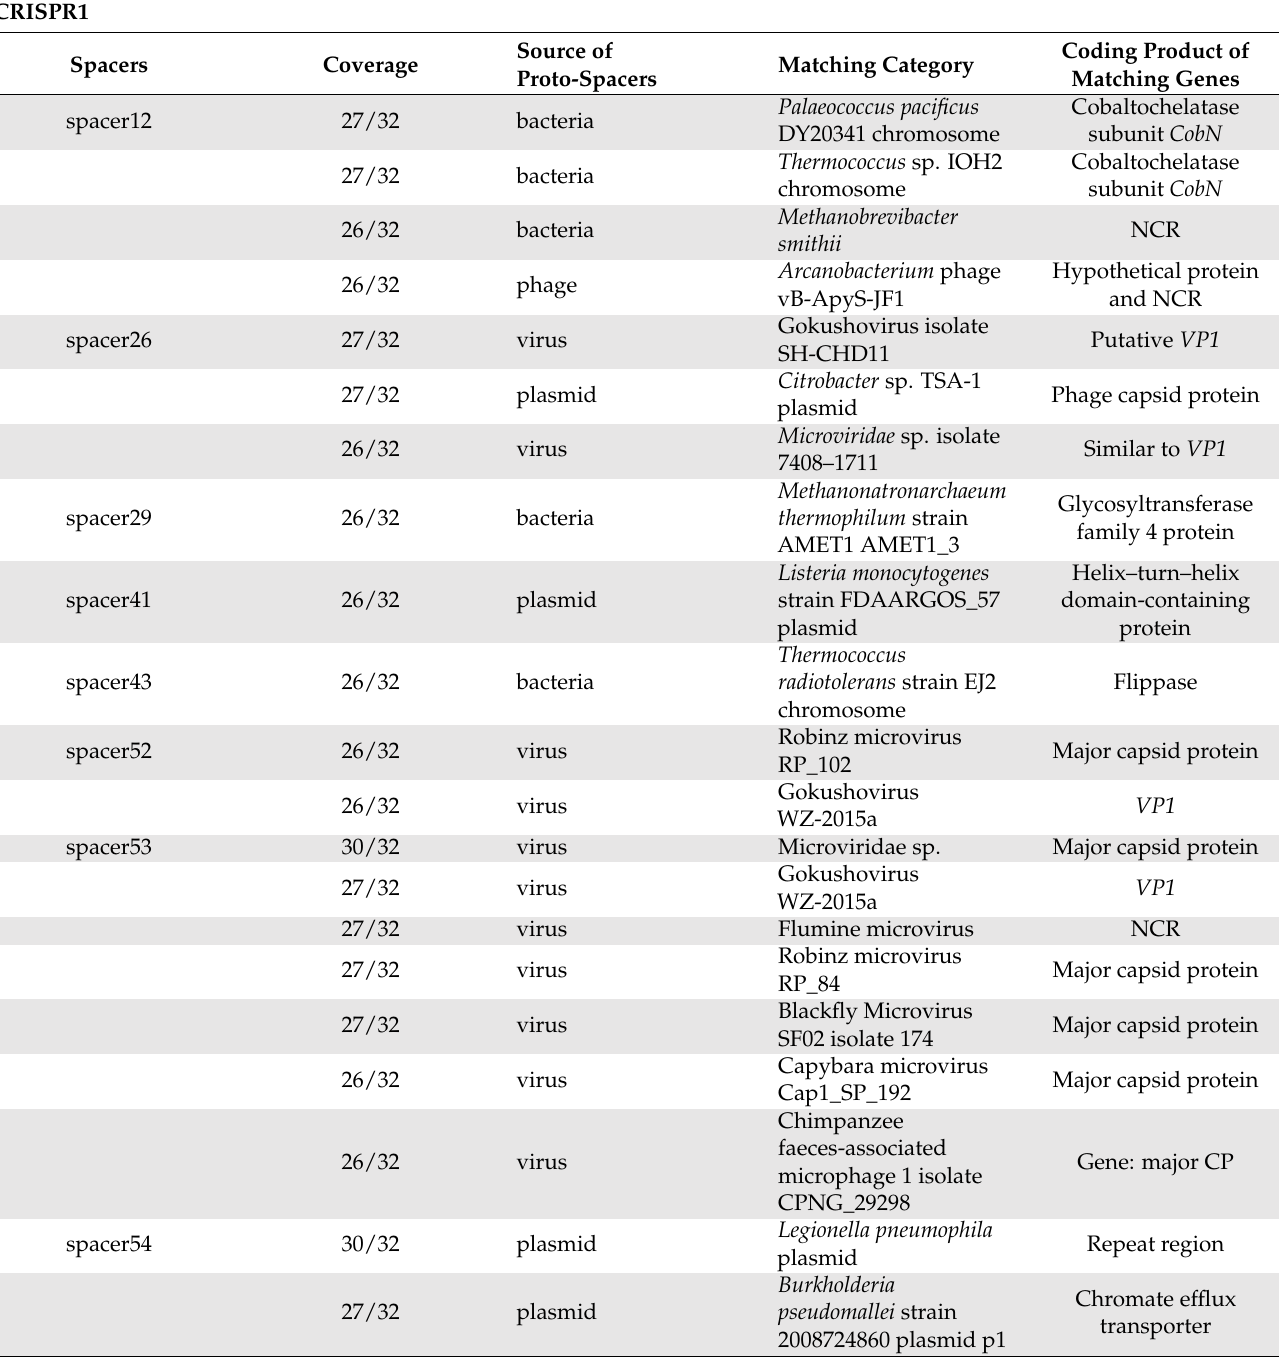
Table 3. Coding products of partially spacer-matched genes in the CRISPR-Cas system of Legionella pneumophila strain Corby